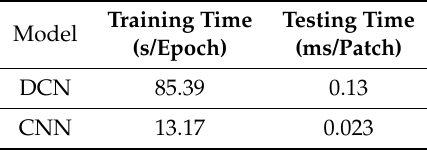
Table 5. Average training and testing CPU times by DCN and